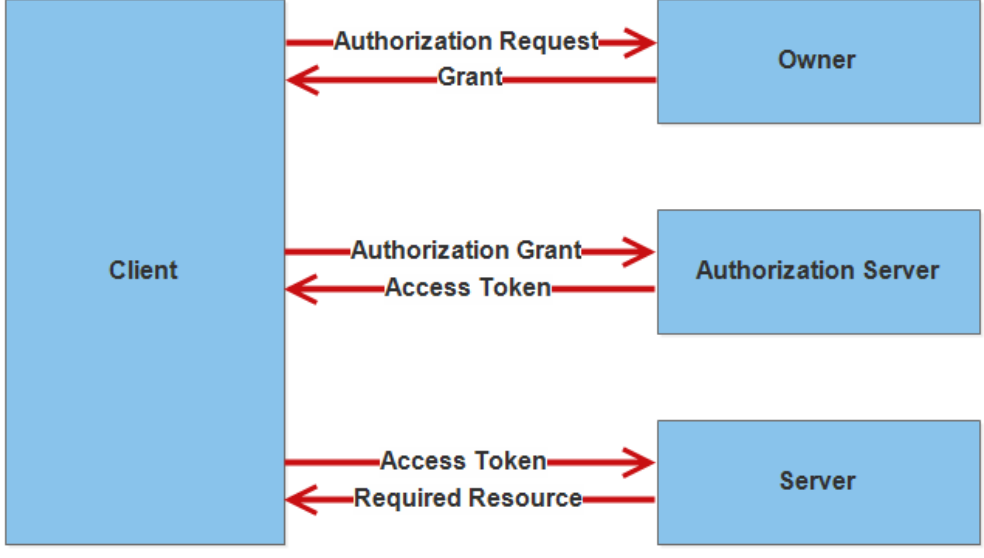
Figure 11. IP based open authorization system for